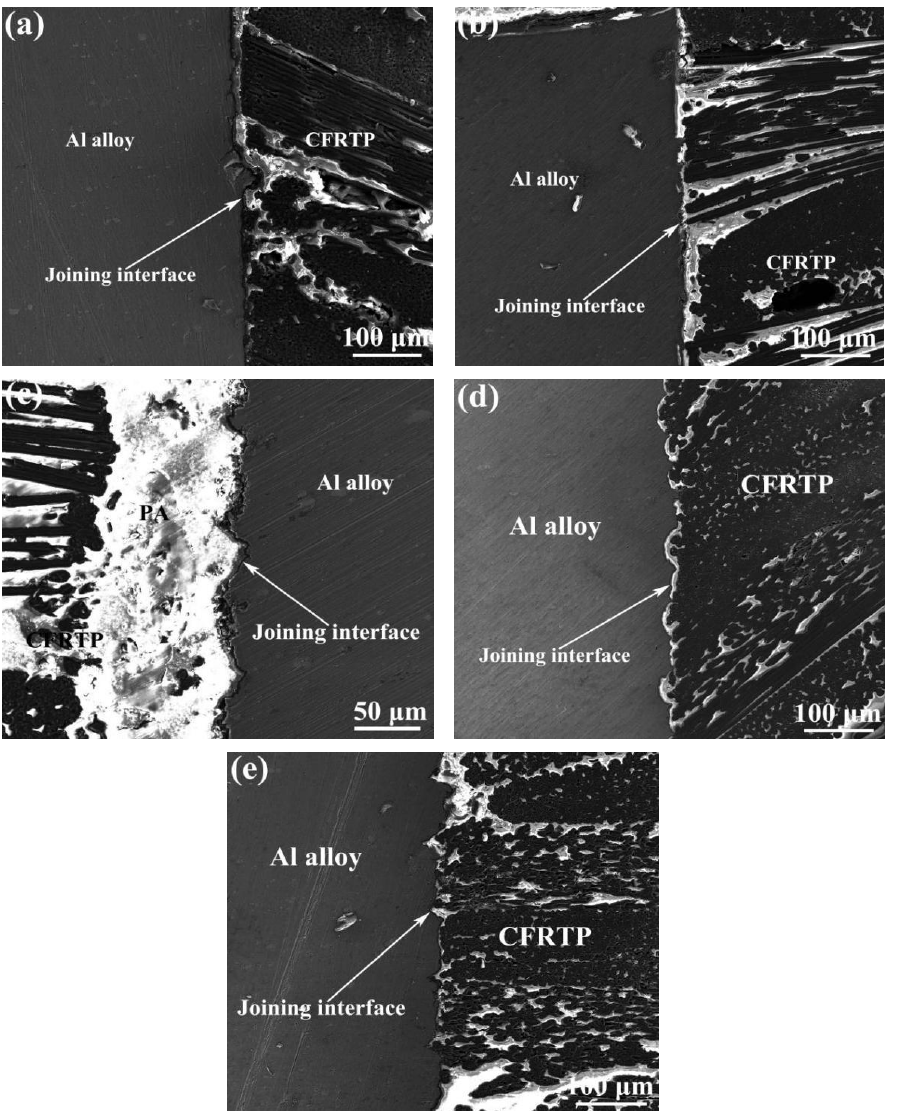
Figure 14. Microstructure of the Al/CFRTP butt joint interface with different pretreatments: ( a ) untreated, ( b ) anodizing of 10 min, ( c ) anodizing of 10 min subsequent followed with laser micro-texture, ( d ) laser micro-texture subsequent followed with anodizing of 10 min, and ( e ) laser micro-texture with scanning distance of 0.1 mm and 1 time laser scanning.